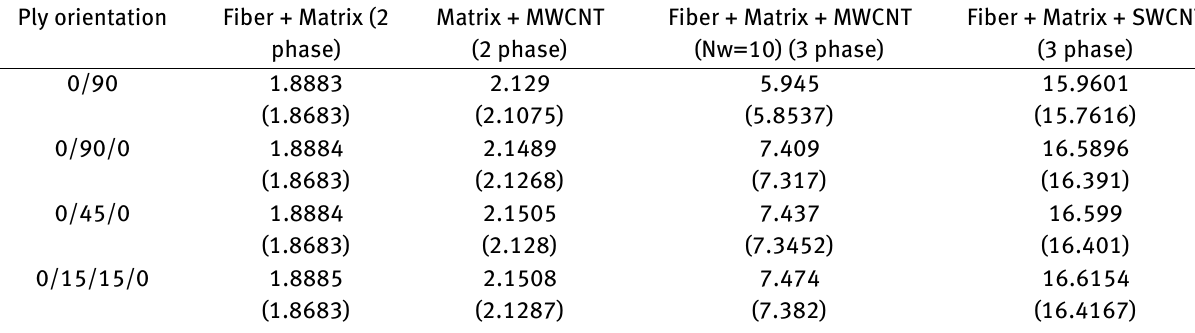
Table 7: Effect of lamination scheme on CBL by using two phase and three phase composite material